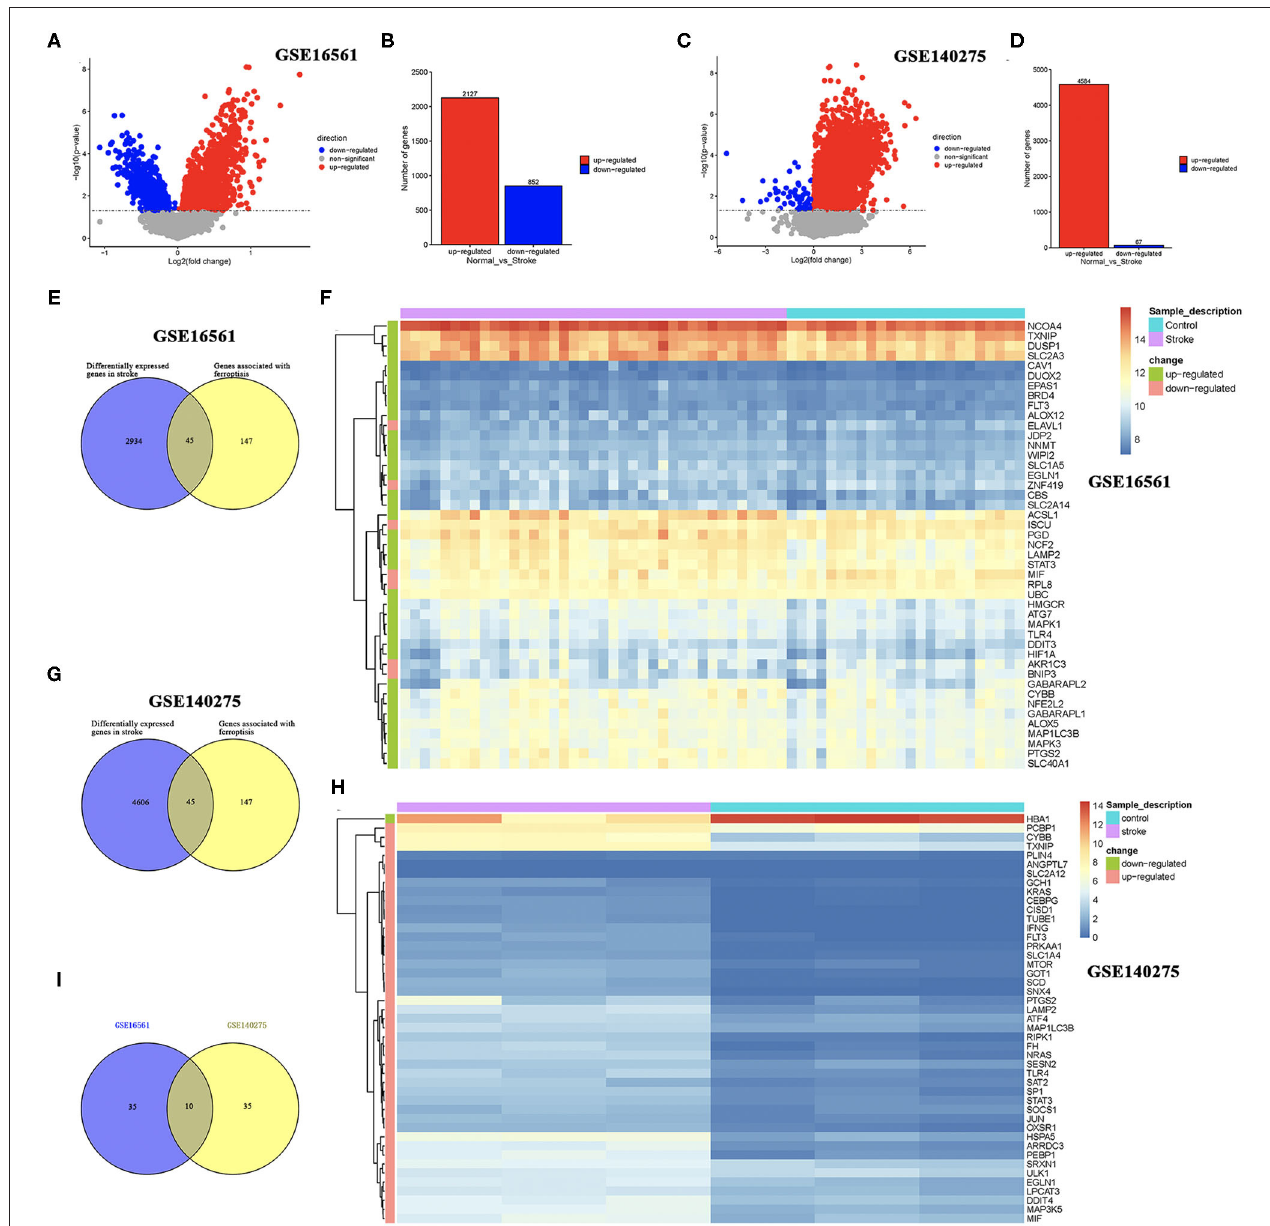
FIGURE 1 | Identification of DEGs and ferroptosis-related DEGs. (A,B) The DEGs between ischemic stroke cohort and normal control cohort in the GSE16561 dataset. (C,D) The DEGs between ischemic stroke cohort and normal control cohort in the GSE140275 dataset. (E,F) The ferroptosis-related DEGs between ischemic stroke cohort and normal control cohort in the GSE16561 dataset. (G,H) The ferroptosis-related DEGs between ischemic stroke cohort and normal control cohort in the GSE140275 dataset. (I) The intersection of ferroptosis-related DEGs in the GSE16561 and GSE140275 datasets. DEGs, differentially expressed genes.